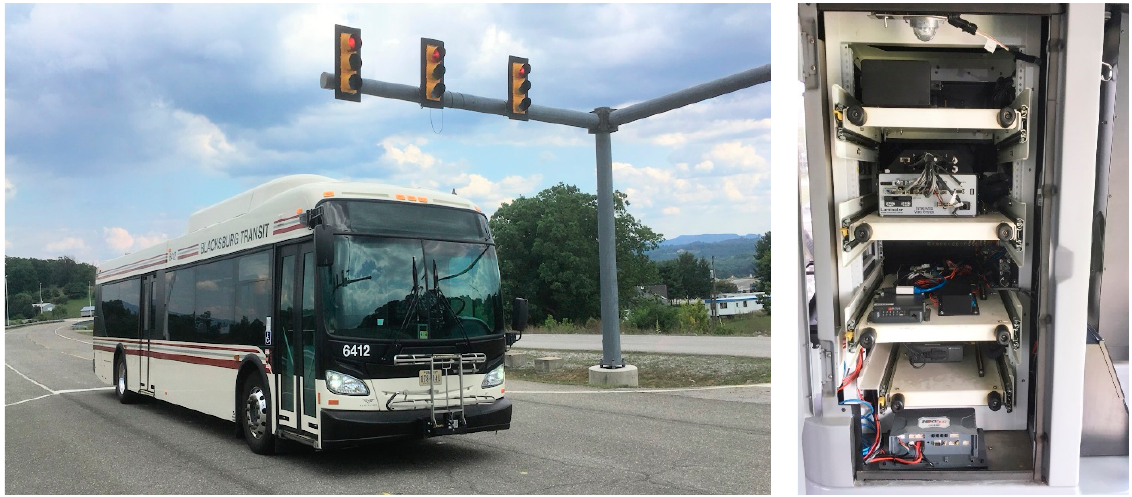
Figure 4. Hardware of the vehicle onboard units in the bus GLOSA